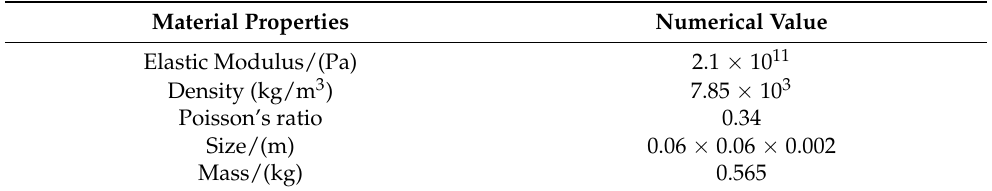
Table 4. Concentrated mass size and material attribute table.